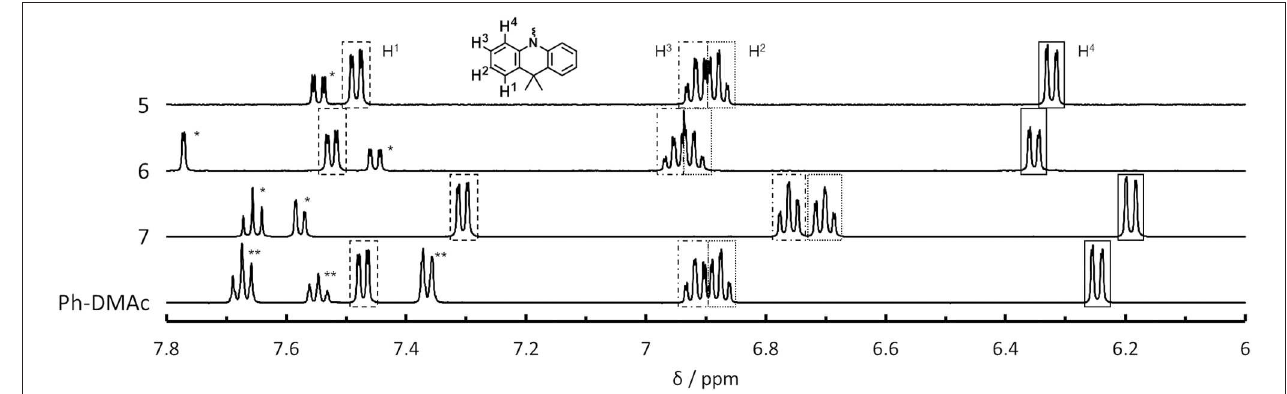
FIGURE 4 | Temperature dependency of transient emission decay of a DPEPO film doped with 7 (6 wt%).